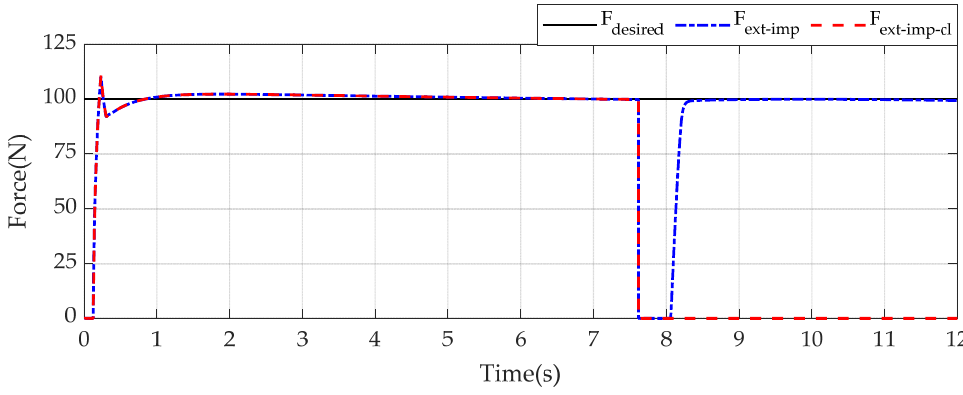
Figure 10. Force tracking effort when considering contact-loss problem.